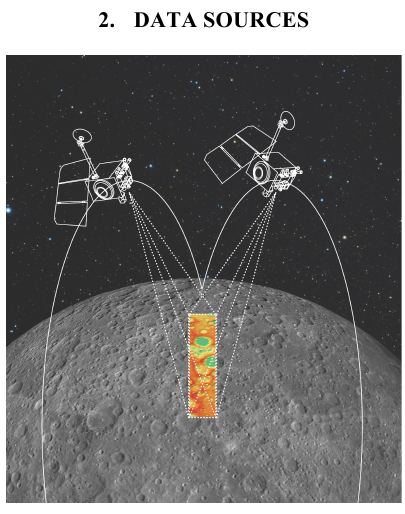
Figure 1. Diagram Illustrating NAC stereo image